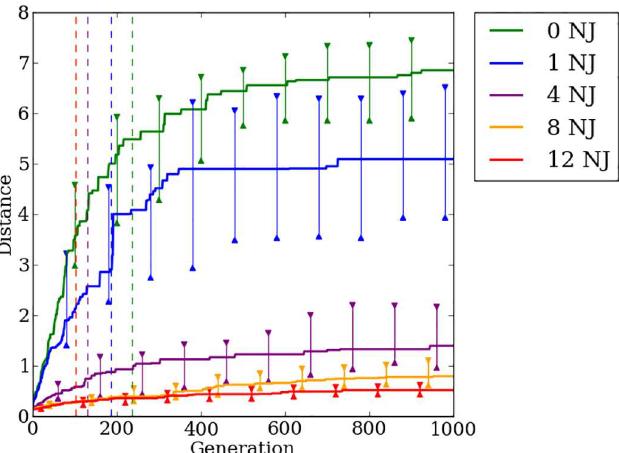
Fig 26. The median distance traveled by Auto-Offset-HybrID generation champions over 1,000 generations on the quadruped robot experiment. The line colors indicate the numberof noisy joints on the robot. The median switch points per treatment are indicatedby dashed lines. 95% bootstrapped confidence intervals of the medianare shown every 100 generations.